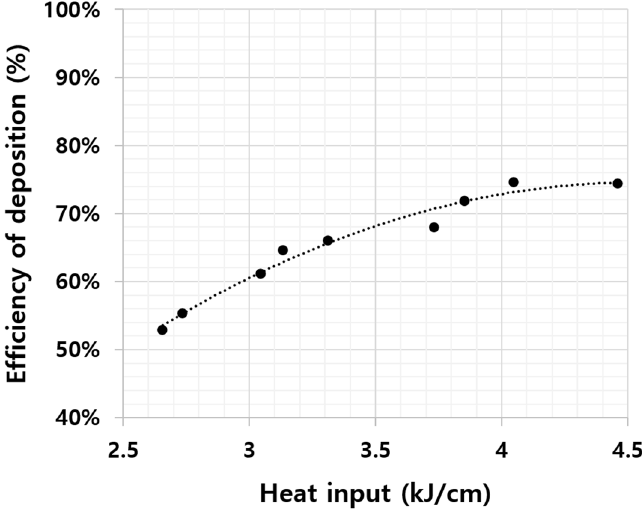
ffi ciency of deposition according to heat input (kJ / Figure 10. Variation of efficiency of deposition according to heat input (kJ/cm). Figure 10. Variation of e